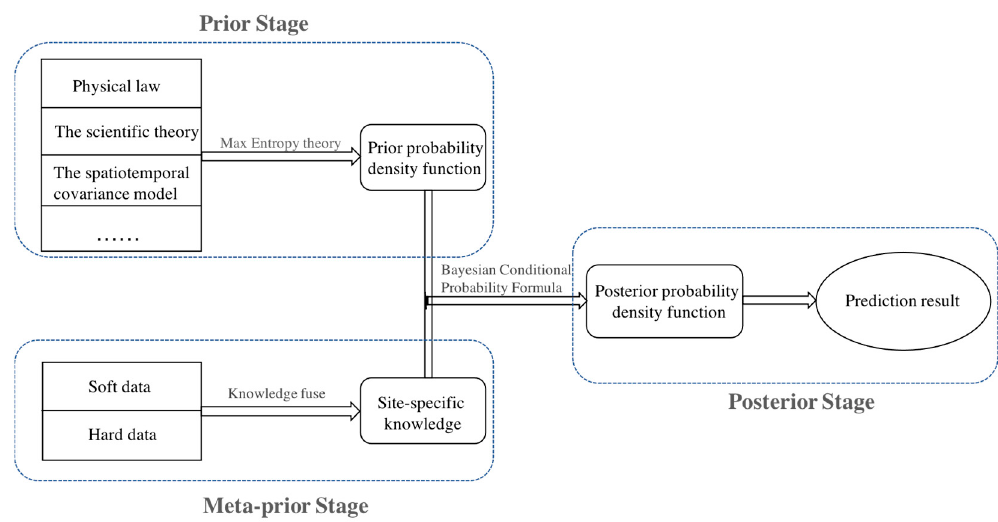
Figure 5. Schematic flowchart for BME.